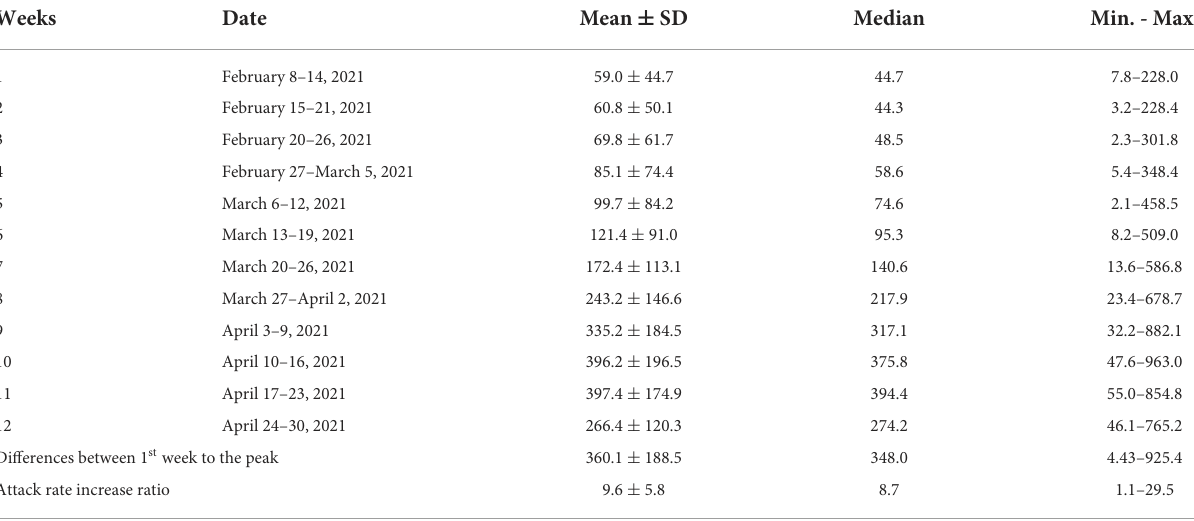
TABLE 2 Descriptive statistics of the attack rates of the COVID-19 (per 100.000 population) by the provinces from February to April 2021 in Turkey.